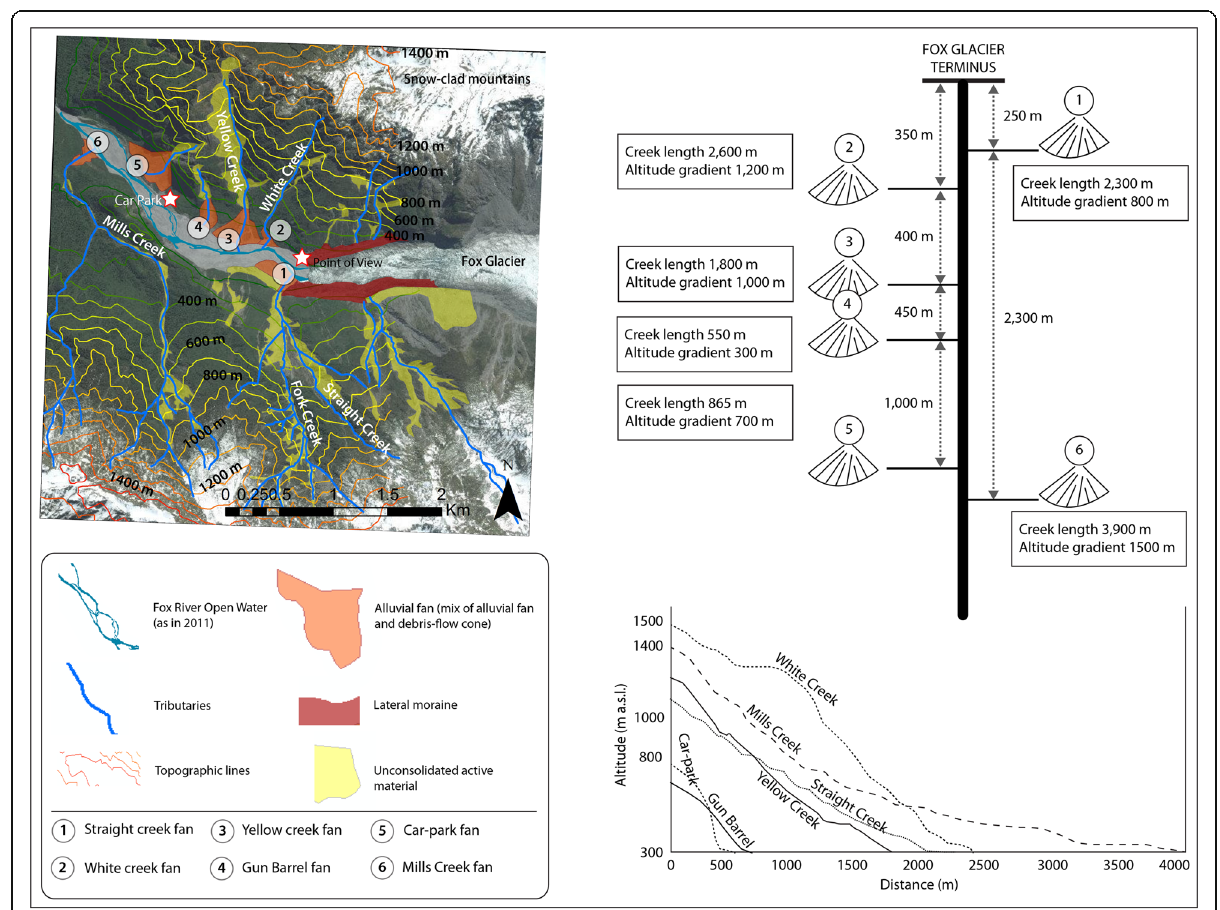
Fig. 3 Presentation of the main tributaries and fans connected to the main Fox Glacier valley, based on the data built for this study. The aerial photograph and the topographic data were first use here in order to introduce the